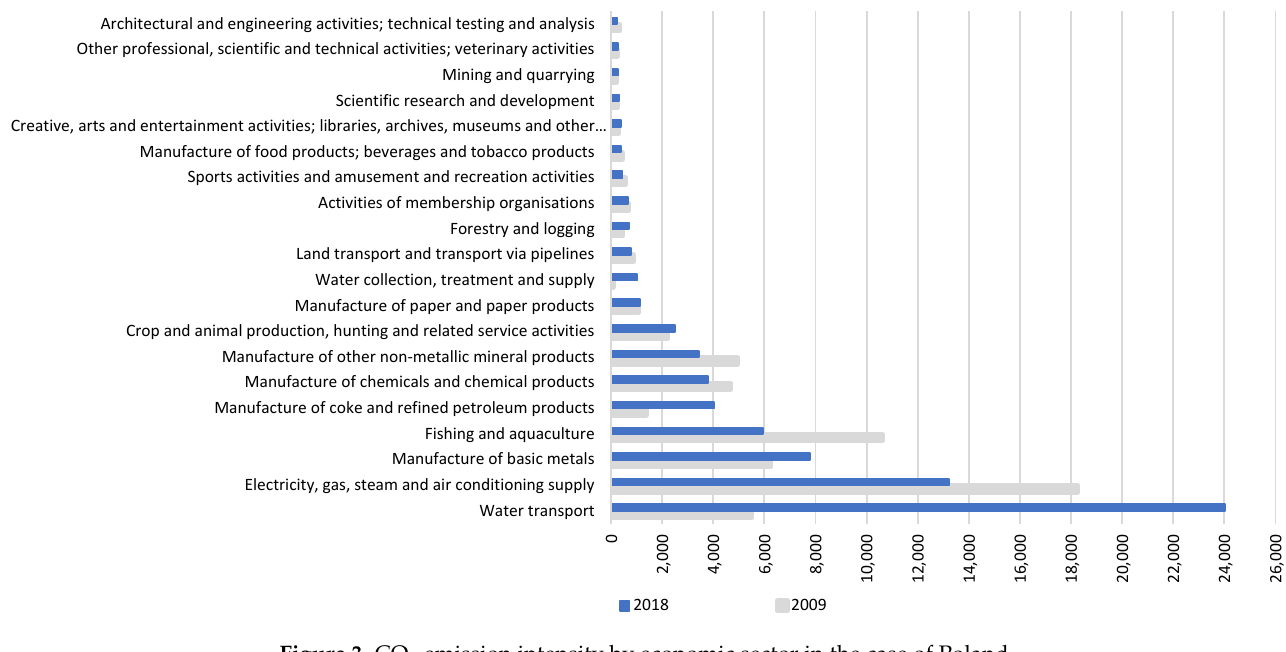
Figure 3. CO 2 emission intensity by economic sector in the case of Poland.